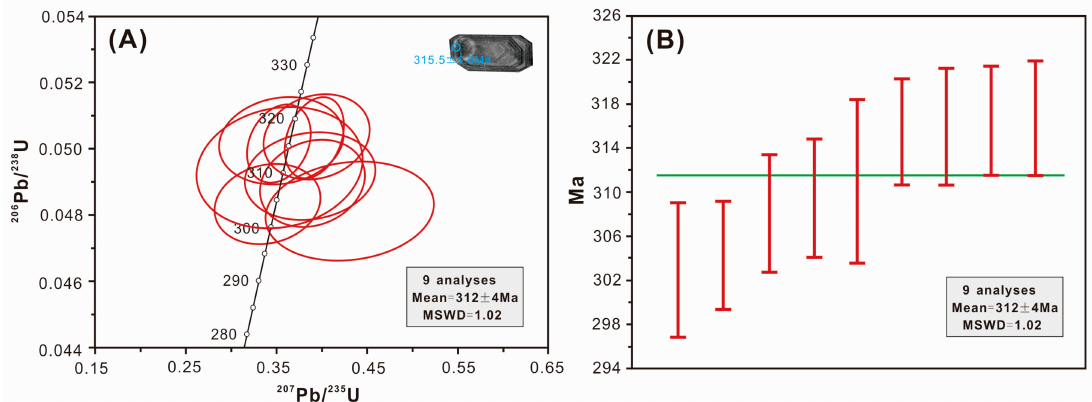
Figure 10. Zircon SIMS U–Pb Concordia diagram ( A , B ) for the dated volcanic rocks (LC09-102) from the Early Carboniferous Yiliu Formation in Laochang